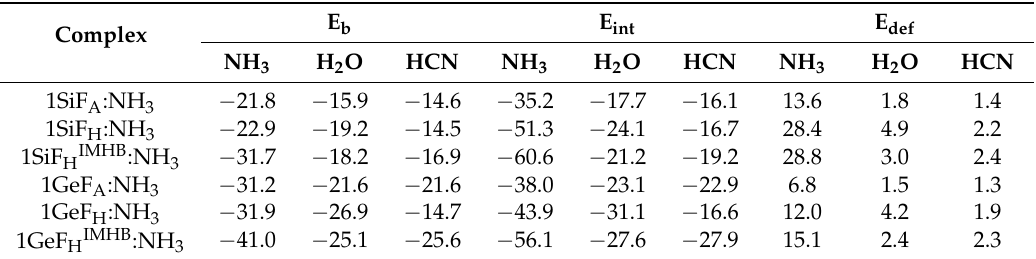
Table 3. Binding energies (E b ), interaction energies (E int ) and deformation energies (E def ) for the 1TF:LB complexes at the MP2/CBS computational level, in kJ · mol − 1 .